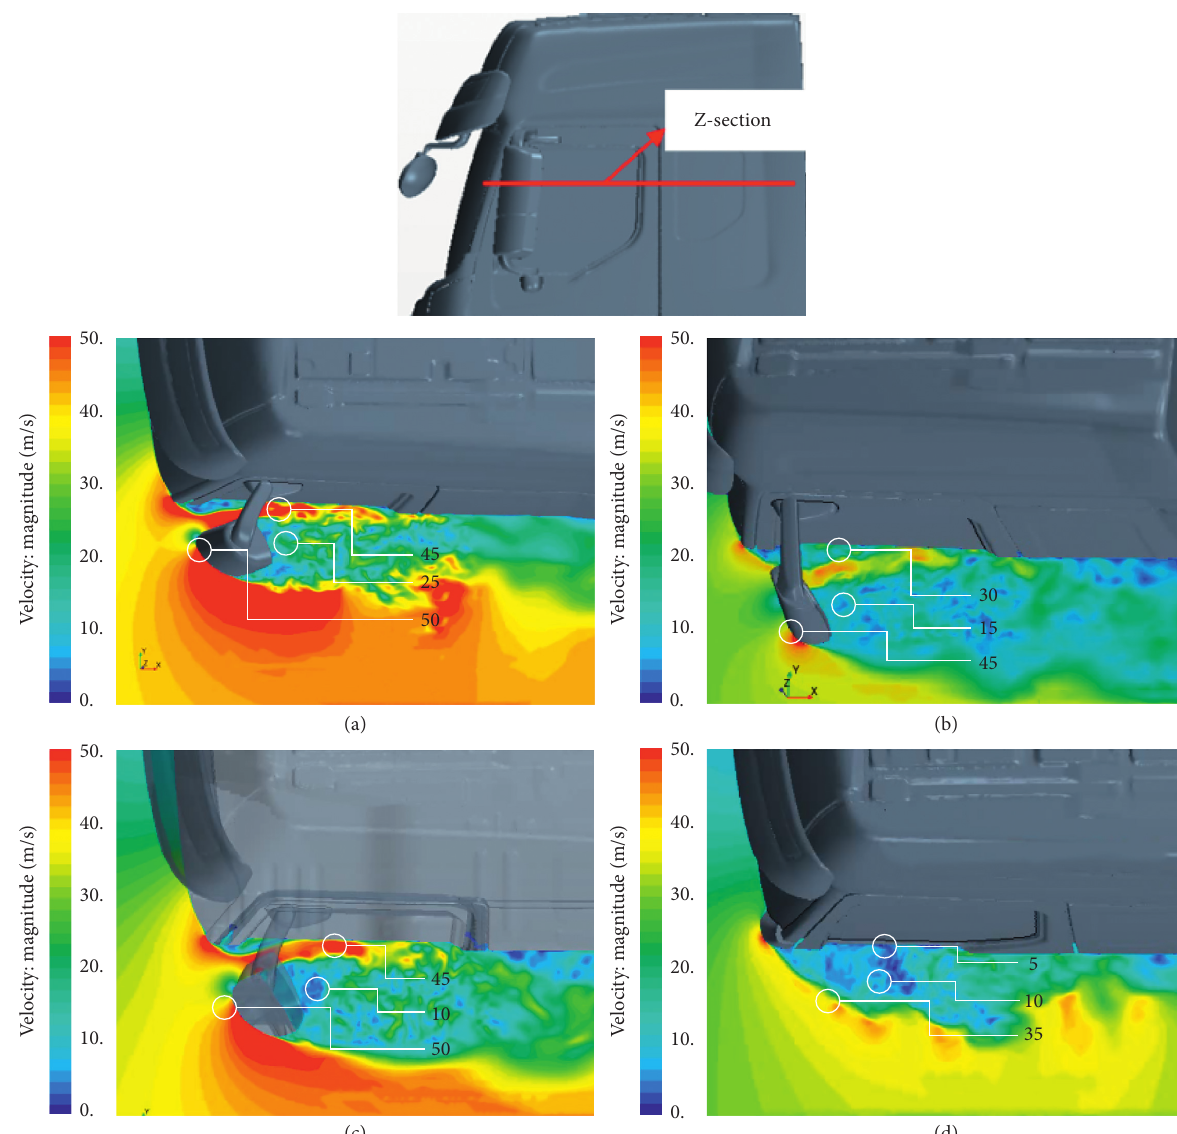
Figure 6: The transient velocity cloud for the three OSRVM and NO SORVM cases with three labeled velocities. (a) OSVRM A. (b) OSRVM B. (c) OSRVM C. (d) NO